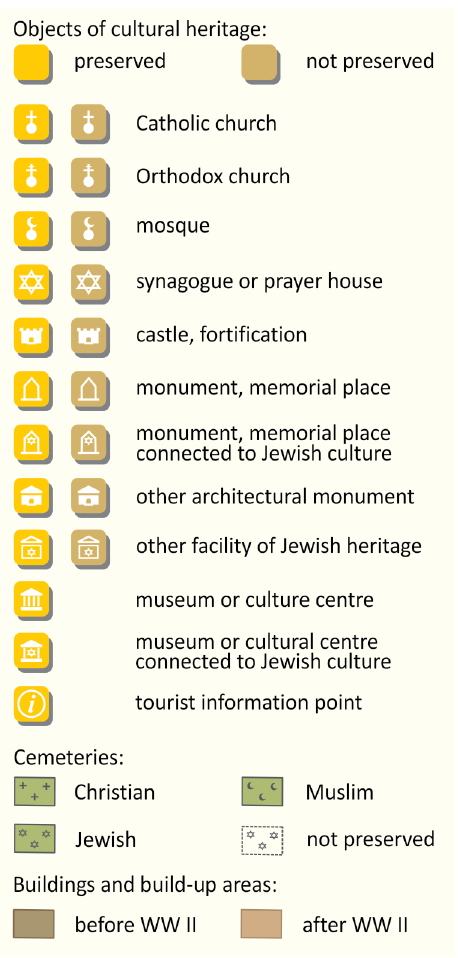
Fig. 3. The common legend for all 63 town maps in the Shtetl Routes guidebook (thematic features